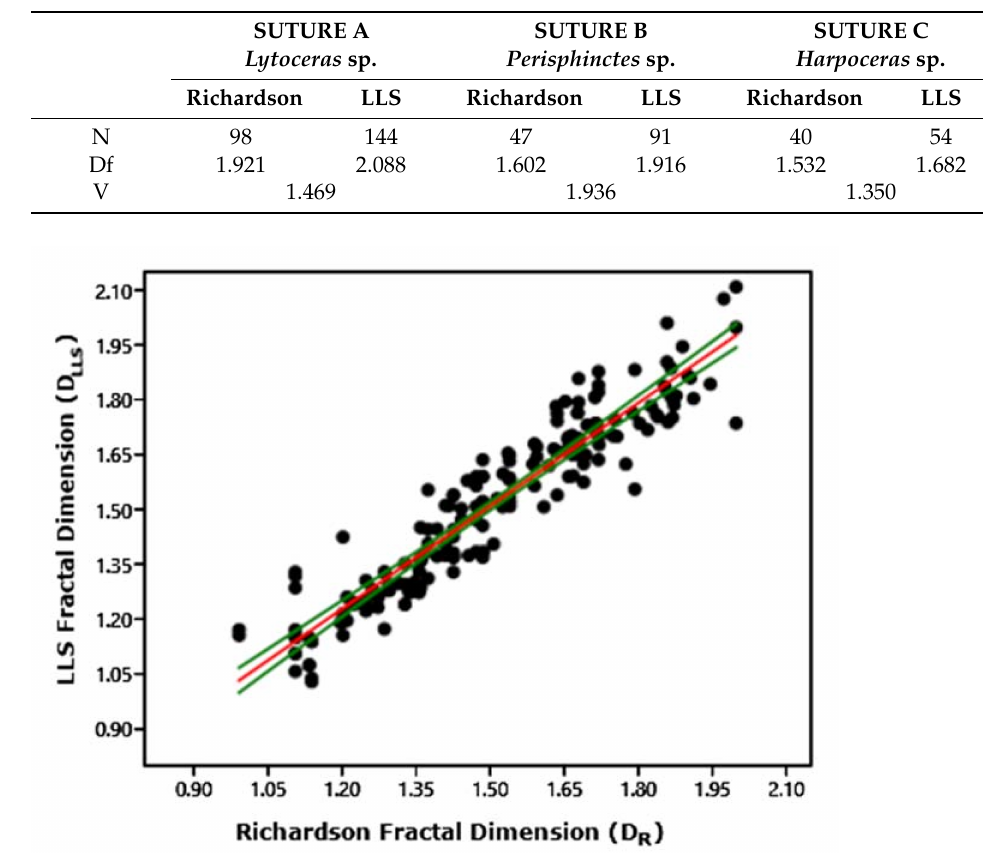
Figure 5. A least-squares plot of the fractal dimensions of ammonite hemisutures versus lateral lobe–saddle pairs using the appropriate conversion values from Table 1, using the program PAST [44]. r 2 = 0.88143 for all genera together. The green lines are bootstrapped 95% confidence